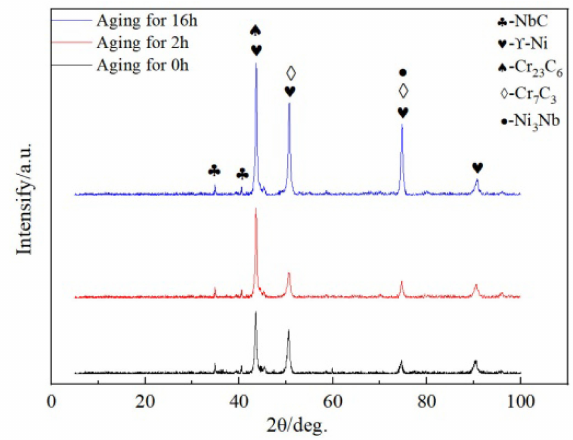
Figure 20. XRD spectrum of Cladding layer 5# after aging treatments of 0 h, 2 h, and 16 h.